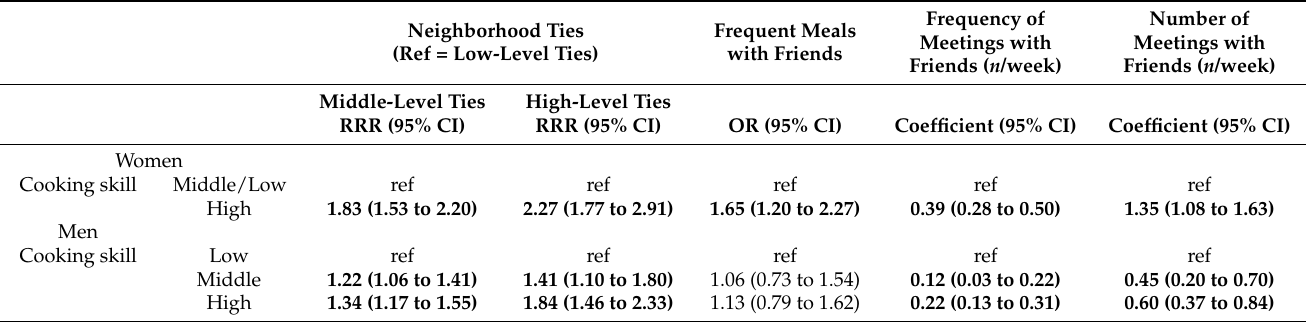
Table 1. Associations of cooking skill with neighborhood ties, frequent meals with friends, and frequency and number of meetings with friends among older adults in